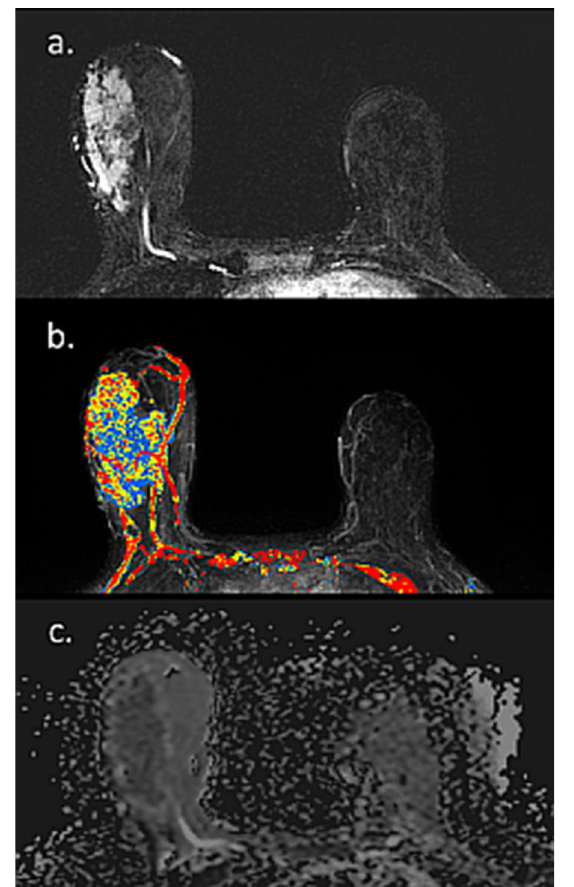
Fig. 18 MRI of delayed diagnosed IDC during lactation. Axial Fig. 19 MRI of delayed diagnosed IDC during lactation. Axial